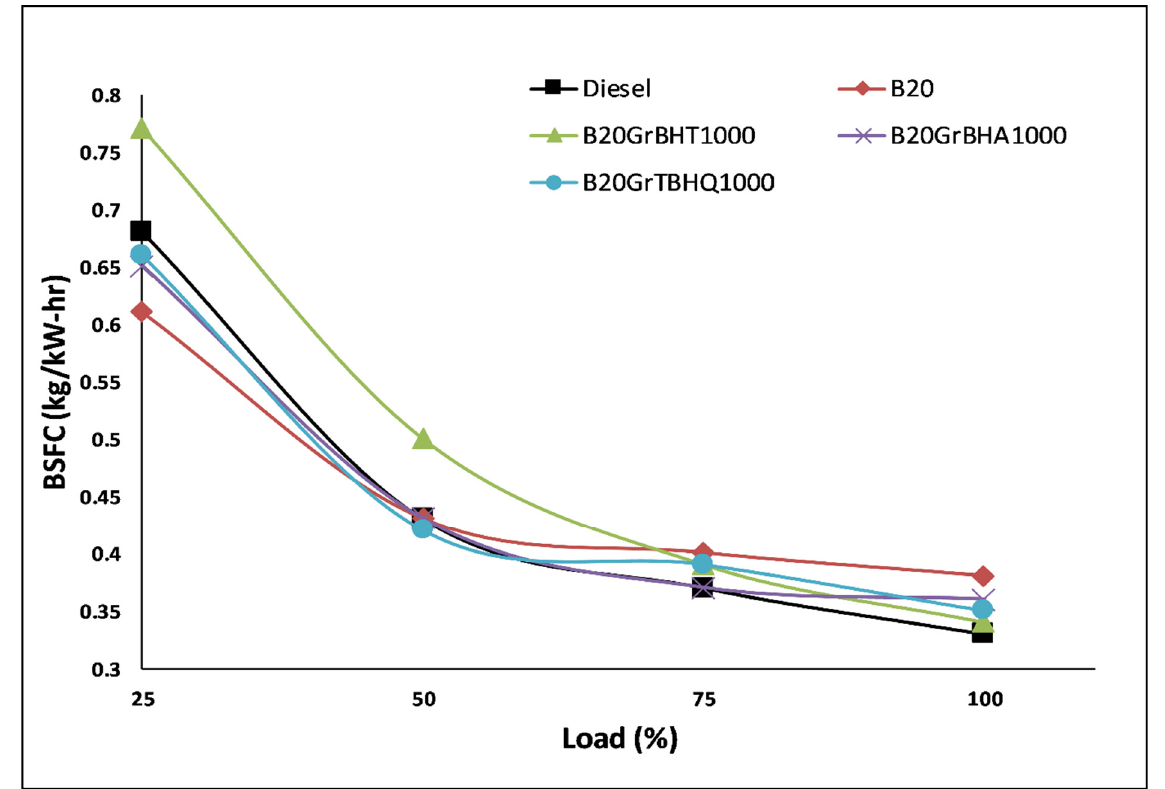
Figure 4. Deviation of brake specific fuel consumption with load .